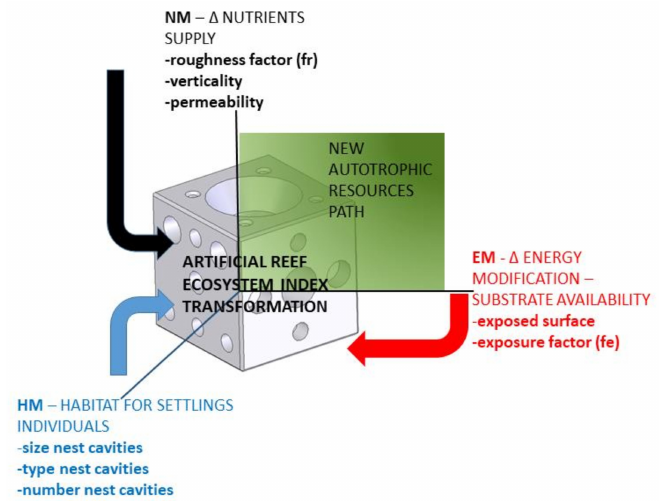
Figure 3. Graphical representation proposal for the AREIT partial indices: EM (energy modification), NM (nutrient modification) and HM (habitat modification) including the most important factors that affect each one of the